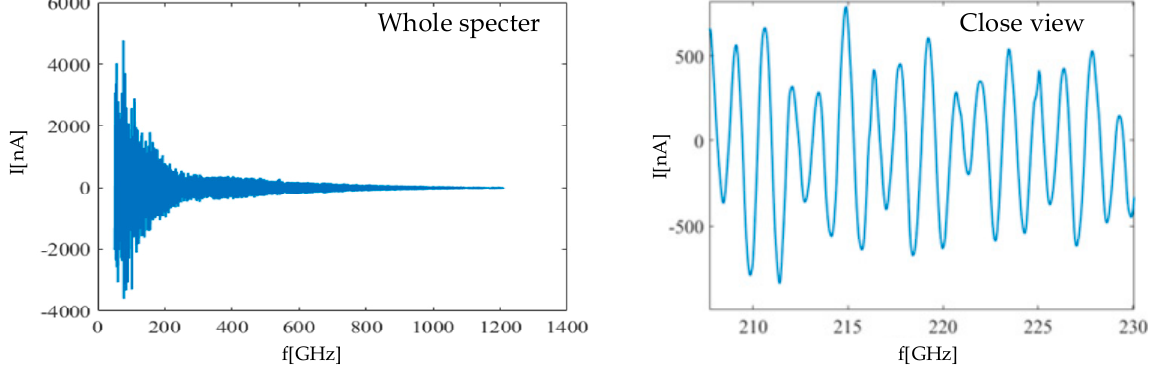
Figure 6. THz frequency sweep-phase fringes.